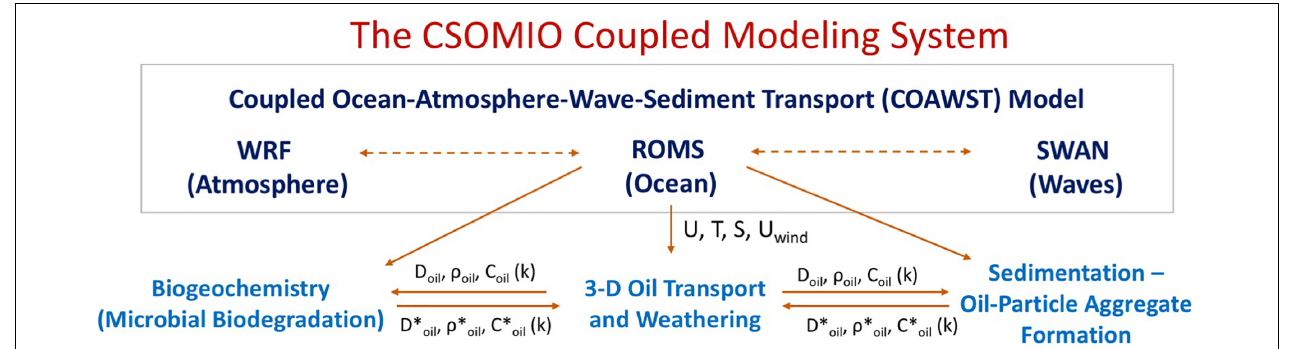
FIGURE 1 | Chart diagram presenting the CSOMIO modeling system and interaction among the components.